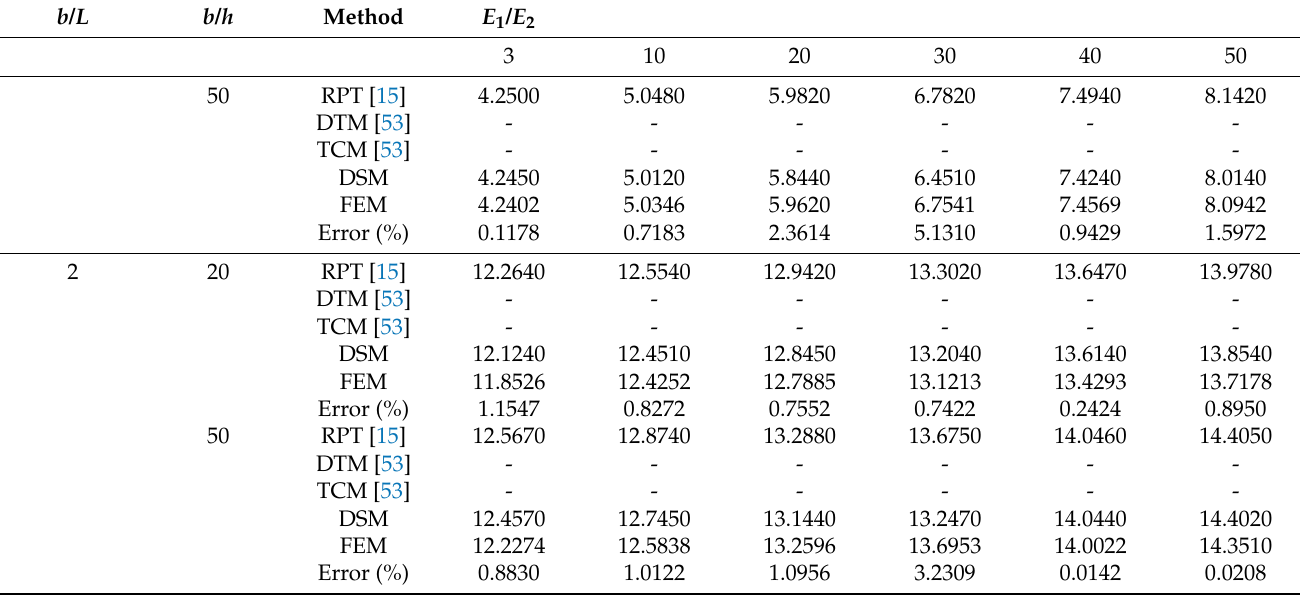
(cid:113) ρ (cid:16) (cid:17) (cid:118) = ω b 2 of an orthotropic E 2 h